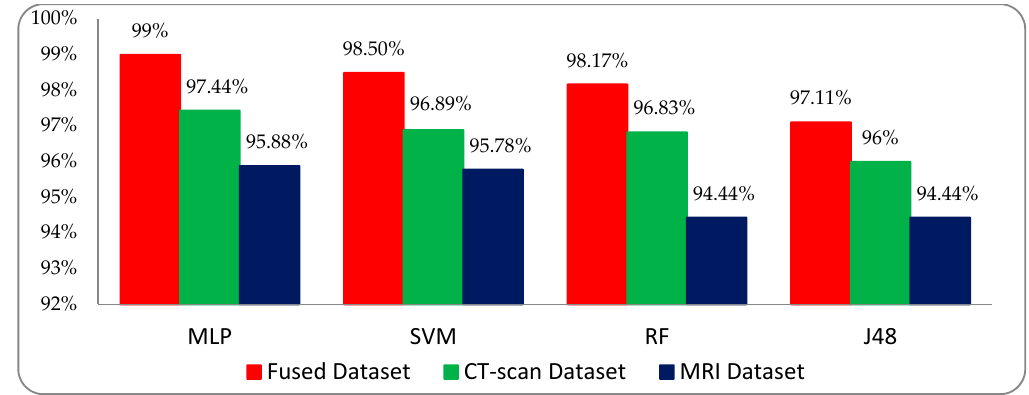
Figure 10. Comparative analysis of the liver cancer classification accuracy graph among different